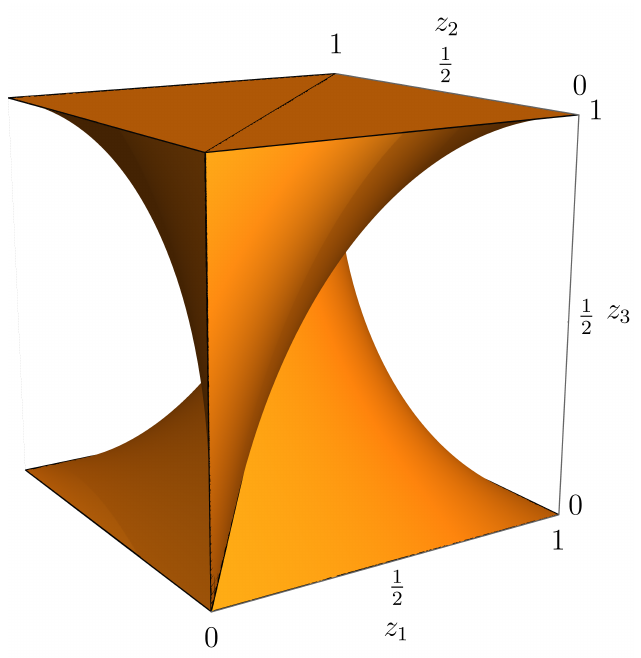
) -space where the exponent Trop can be , y , y 1 2 3 . They should be viewed as one 2